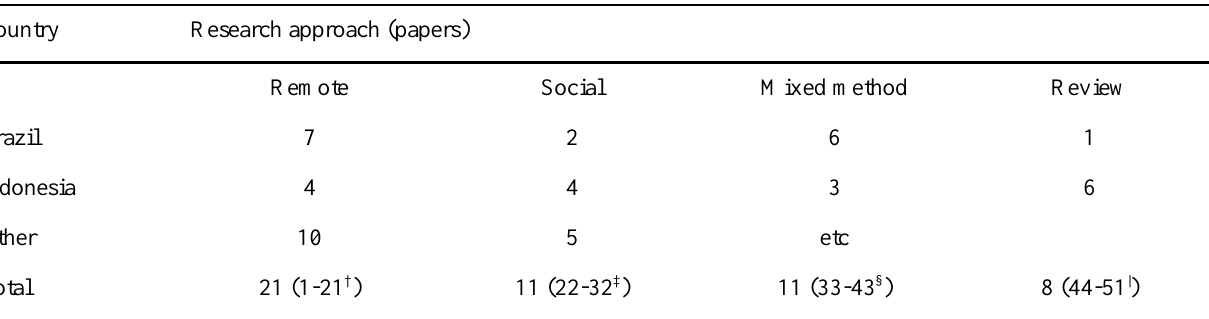
Table 2. Number of papers per research approach category for Brazil, Indonesia, and all countries combined.